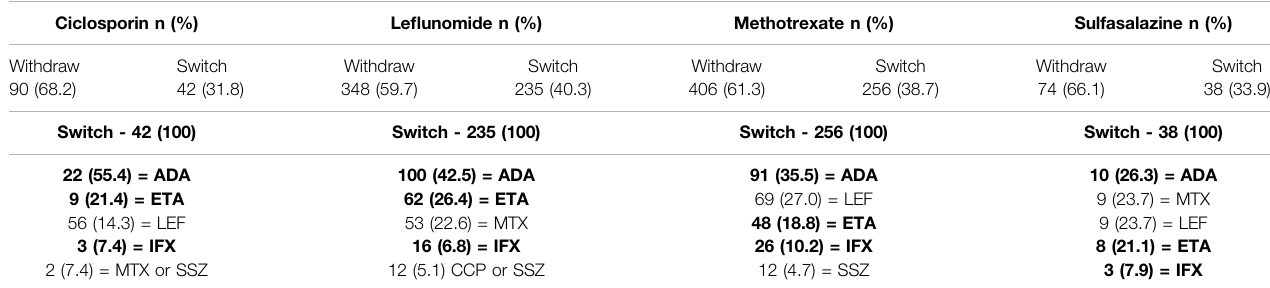
TABLE 4 | Withdrawal and switch treatments at 12 months.